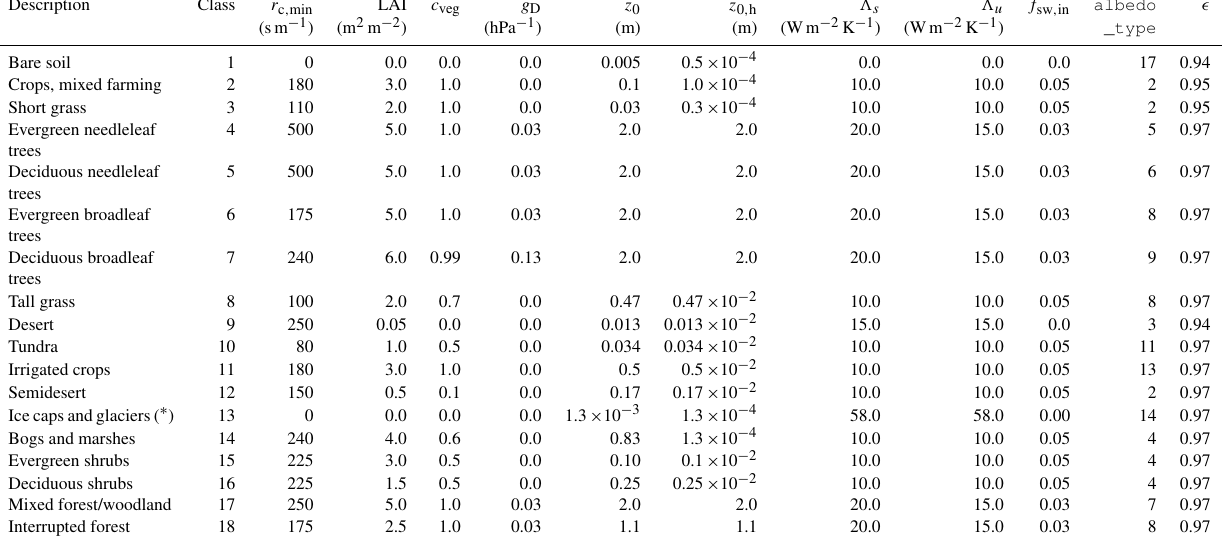
Table A1. Land use classification parameters according to vegetation_type based on the Integrated Forecasting System (IFS) classifi- cation. Note that the land use class 13 (ice caps and glaciers) has not been implemented yet. r c , min is the minimum canopy resistance, LAI is leaf area index, c veg is vegetation coverage, g D is a canopy resistance coefficient, z 0 and z 0 , h are the roughness lengths for momentum and heat, respectively, (cid:51) s and (cid:51) u are the bulk heat conductivities between skin and soil layer for stable and unstable stratification, respectively, f sw , in is the fraction of absorbed shortwave radiation by the vegetation canopy, and (cid:15) is the surface emissivity.